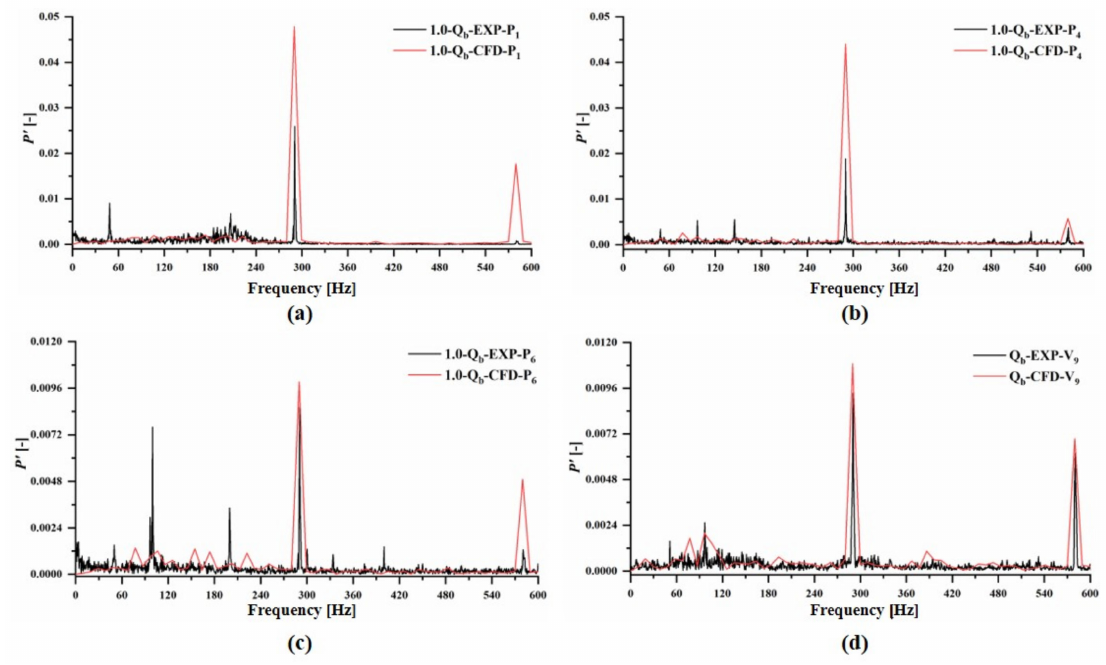
Figure 7. Pressure fluctuations frequency domain signal comparison between CFD and test. ( a ) pres- sure fluctuations coefficient of P1; ( b ) pressure fluctuations coefficient of P4; ( c ) pressure fluctuations coefficient of P6; ( d ) pressure fluctuations coefficient of